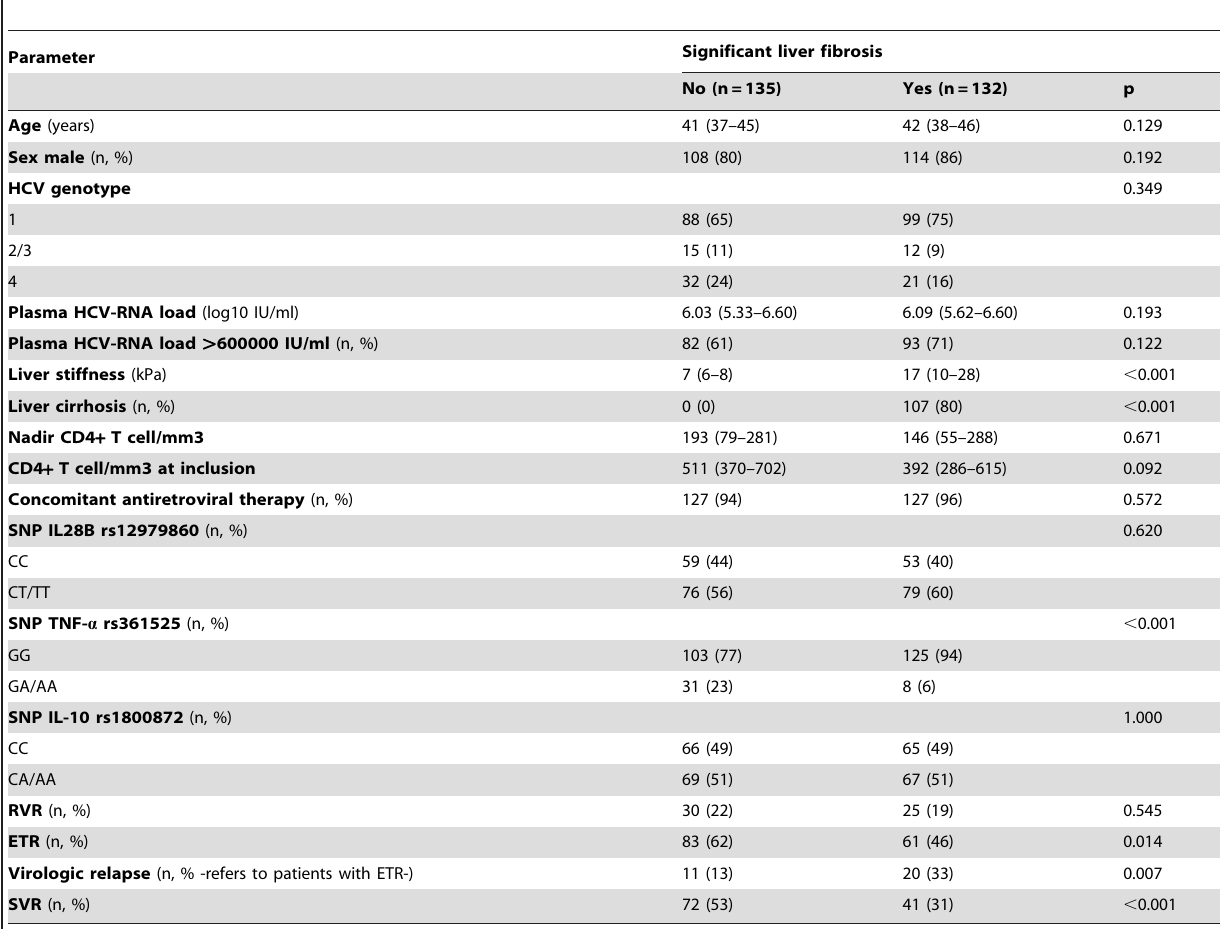
Table 4. Characteristics of HIV-HCV coinfected patients treated with pegylated interferon alpha 2a plus ribavirin (n= 267), distributed as a function of the presence or absence of significant liver fibrosis (F3 or